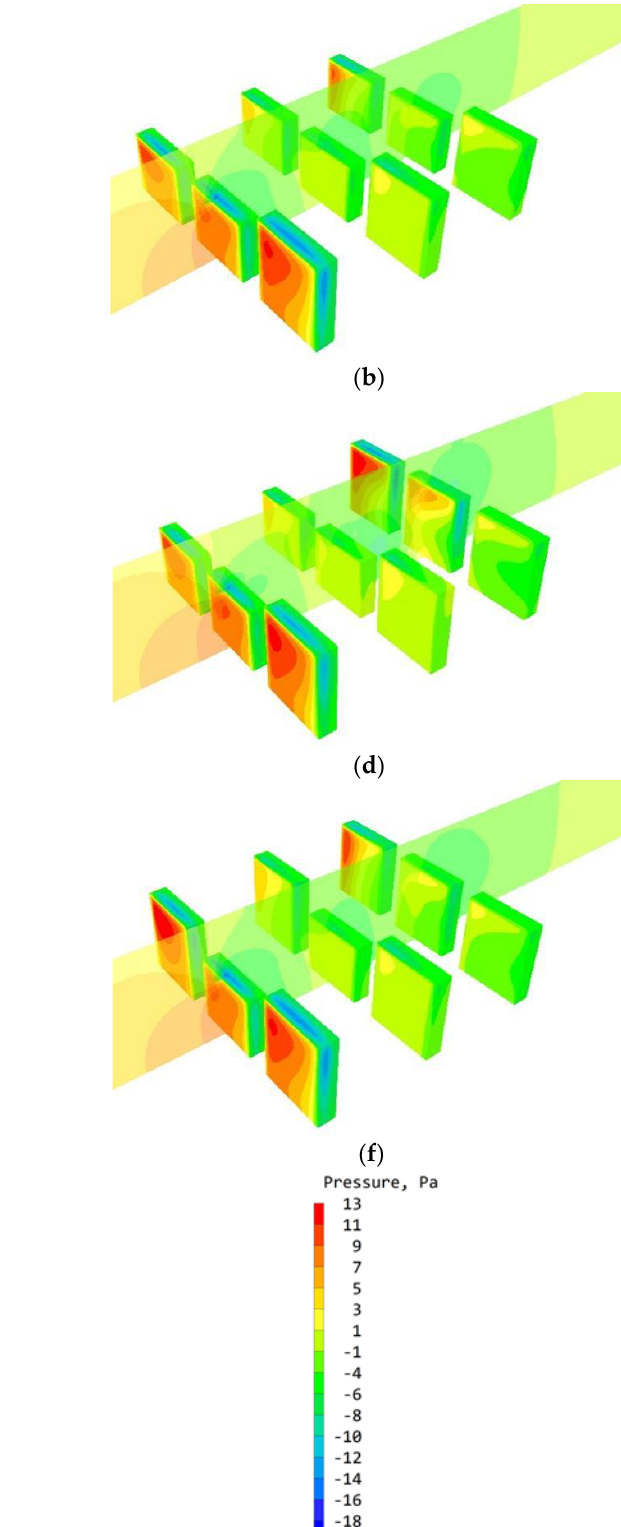
Figure 9. Proportional distribution of wind pressure for the seven building distribution patterns. ( a ) Windward pressure at the building, ( b ) leeward pressure at the building, and ( c ) wind pressure difference at the building.